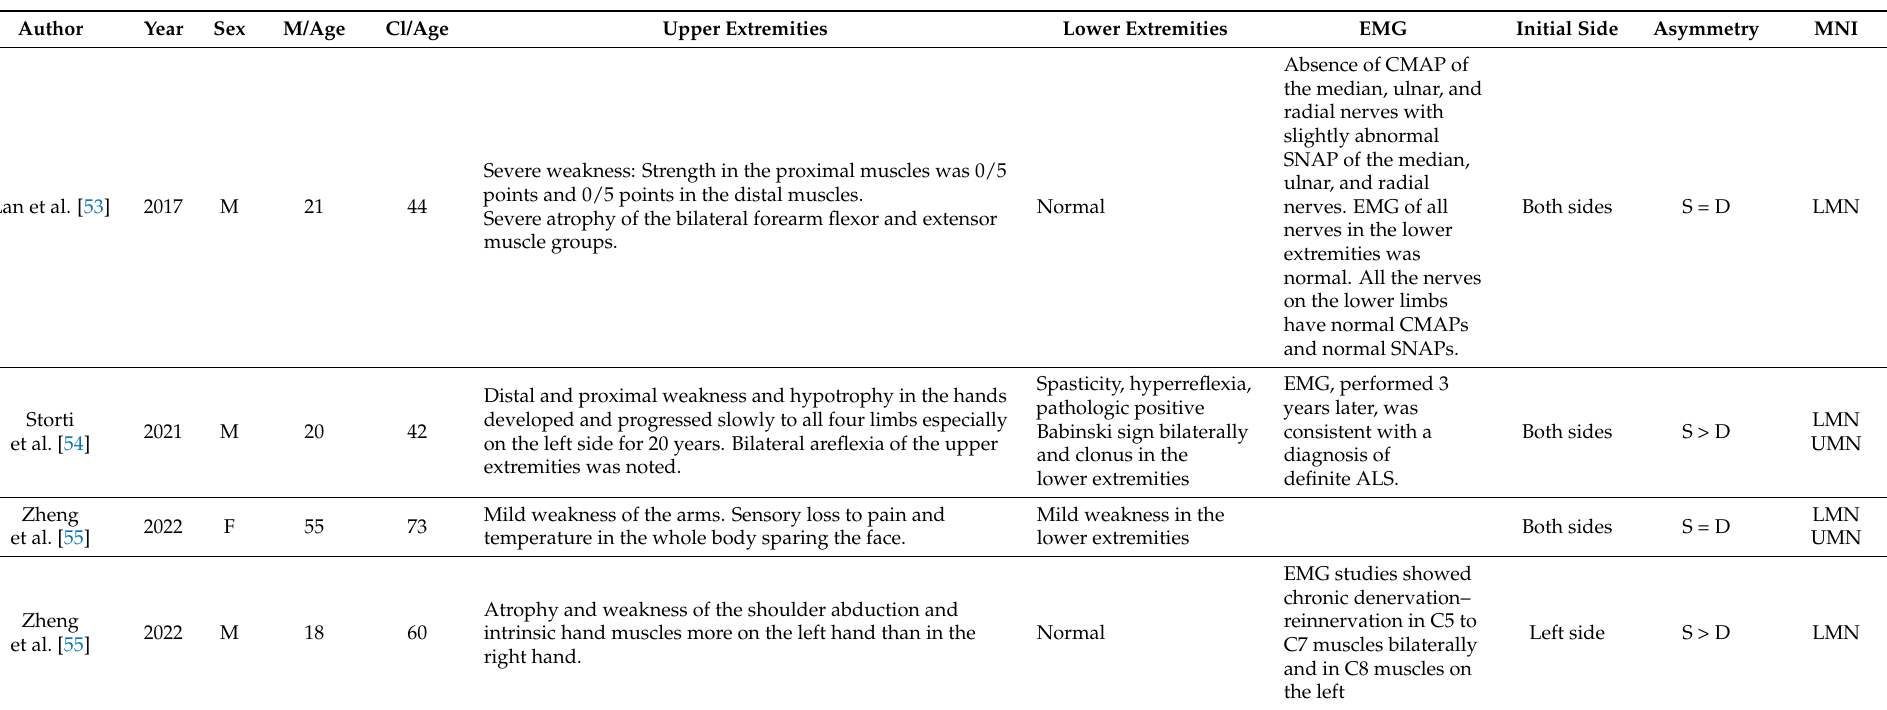
Severe atrophy of the bilateral forearm flexor and extensor muscle